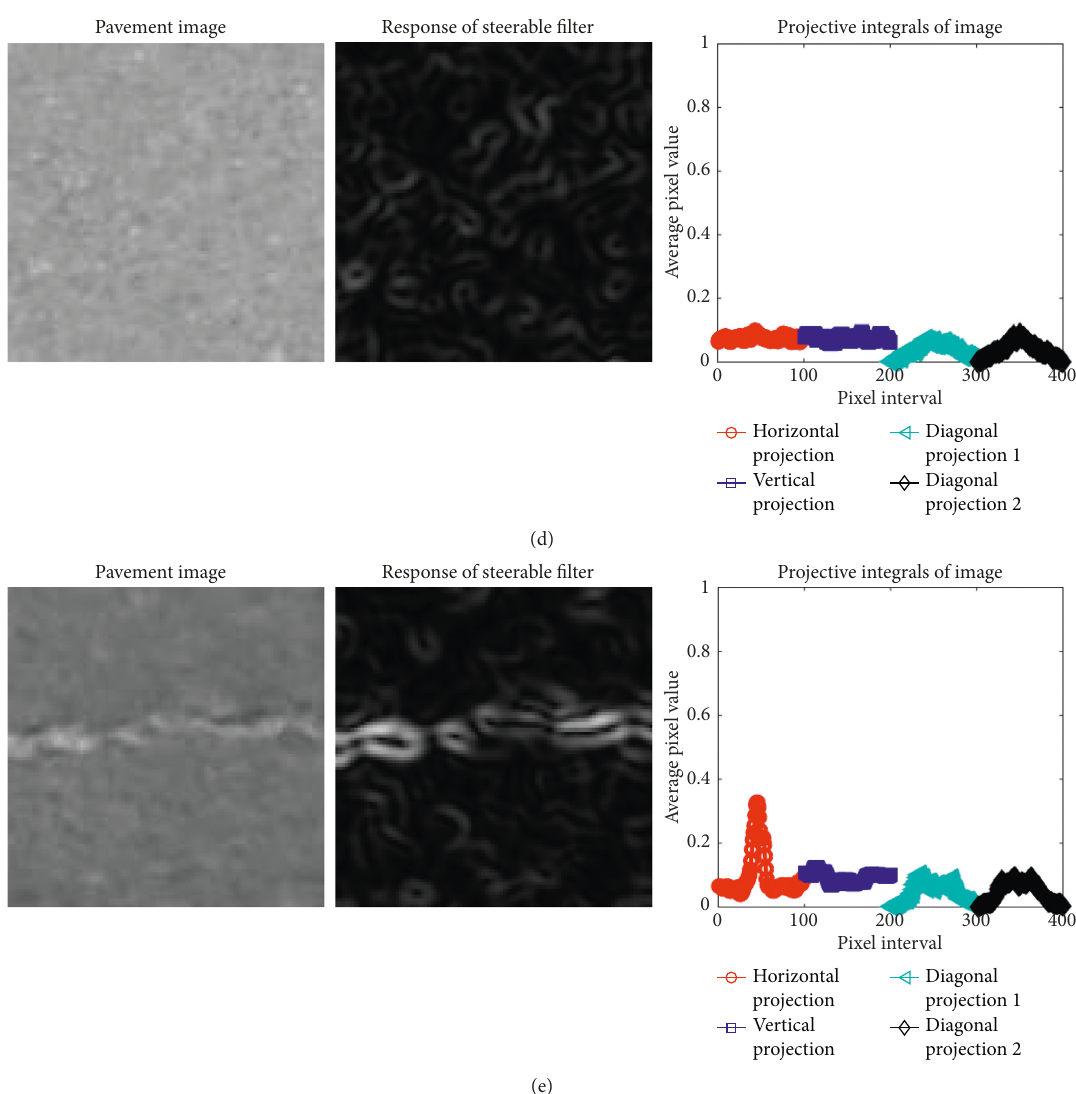
Figure 9: Projection integrals of asphalt pavement images using STF response: (a) alligator crack; (b) diagonal crack; (c) longitudinal crack; (d) noncrack; (e) transverse